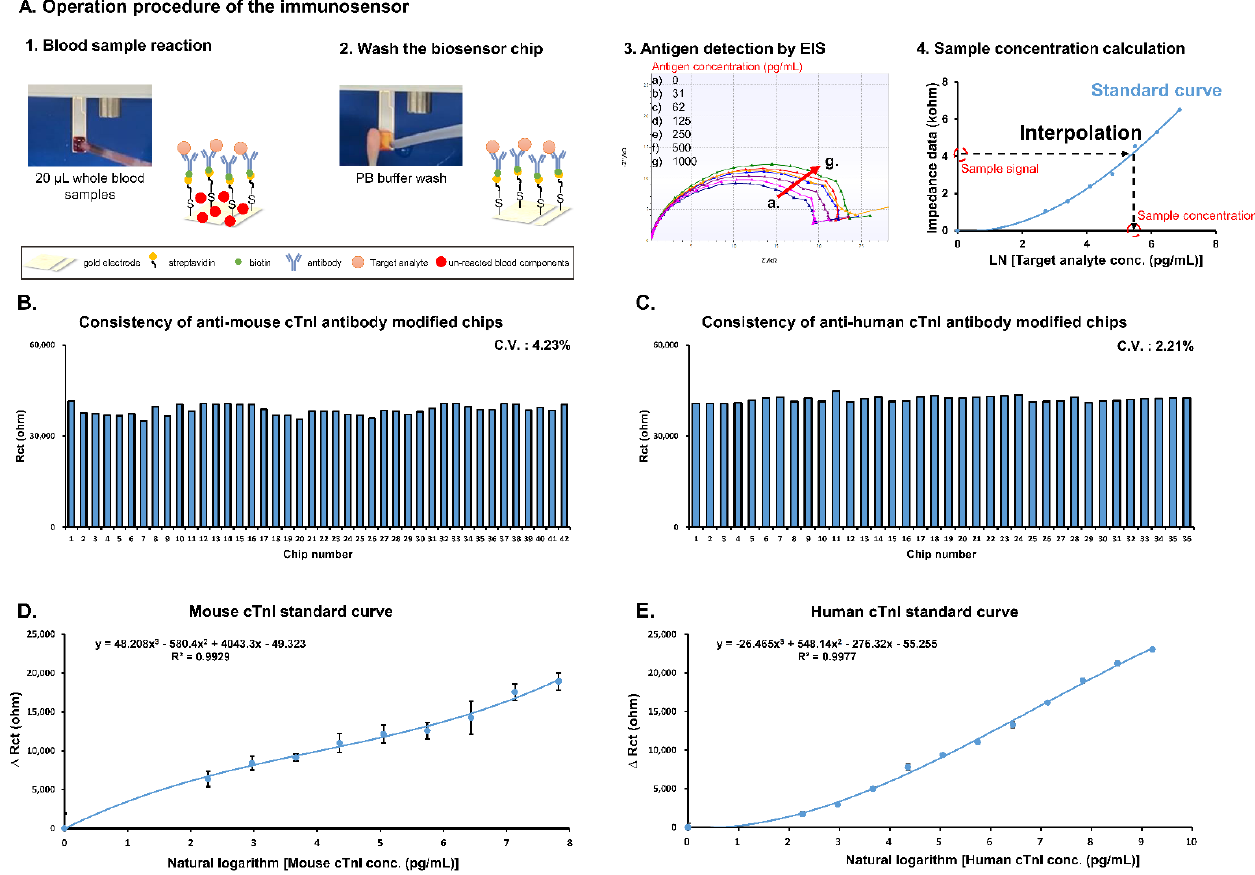
Figure 1. Establishment of immunosensor for cTnI detection in whole blood samples. ( A ) Detection procedure used to obtain standard curves. ( B ) Investigation of consistency of individual anti-mouse cTnI antibody modified biochips after functionalization. ( C ) Investigation of consistency of individual anti-human cTnI antibody modified biochips after functionalization. ( D ) Standard curve of mouse cTnI (analysis was performed in triplicate). ( E ) Standard curve of human cTnI (analysis was performed in